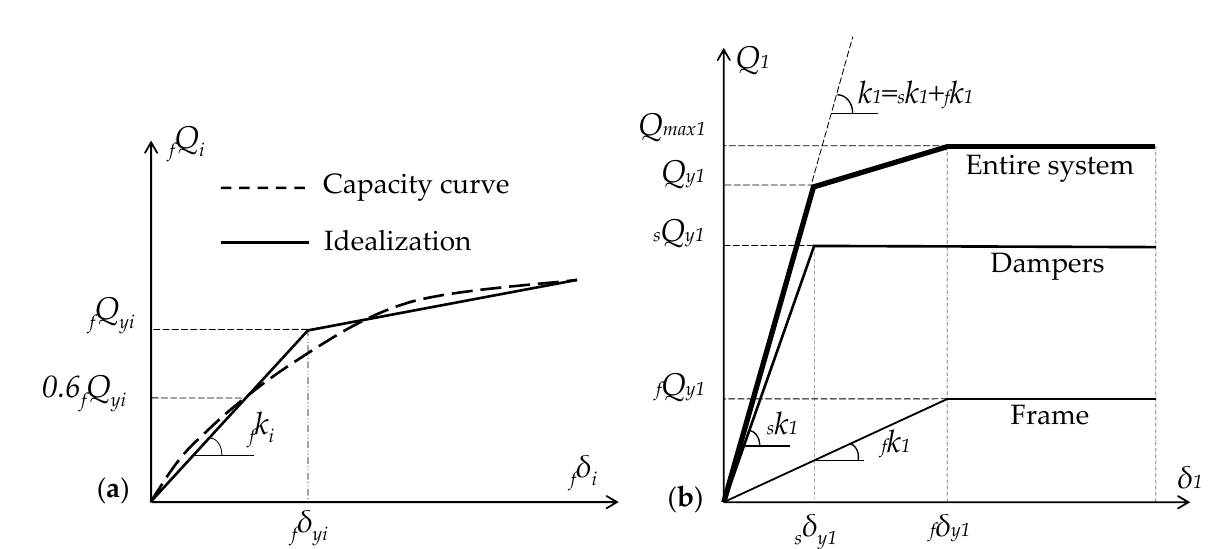
Figure 2. Force–displacement relationships: ( a ) at the upper i -th story; ( b ) at the first Figure. 2 : Force-displacement relationships: ( a ) at the upper i -th story; ( b ) at the first story